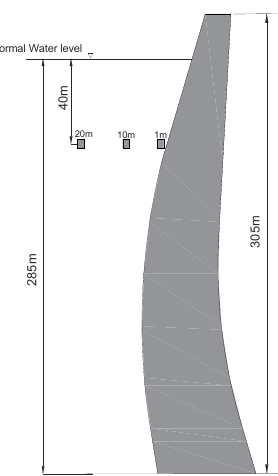
Figure 17. Position of detonation at various detonation distances.